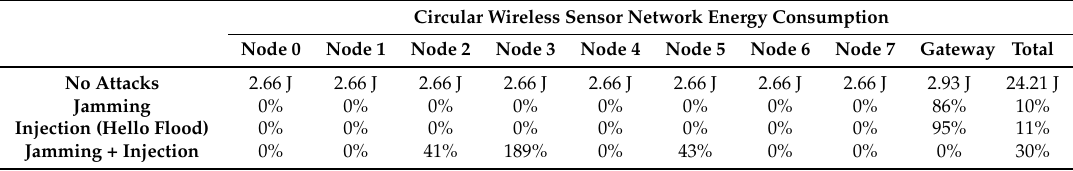
Table 5. Energy Consumption estimations for Circular